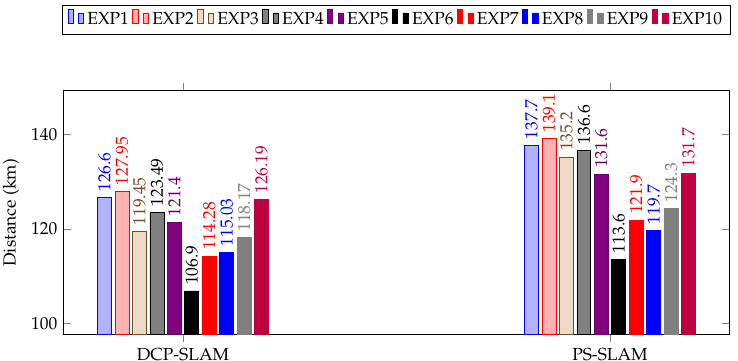
Figure 9. Comparative results of distance travelled by the swarm as a whole